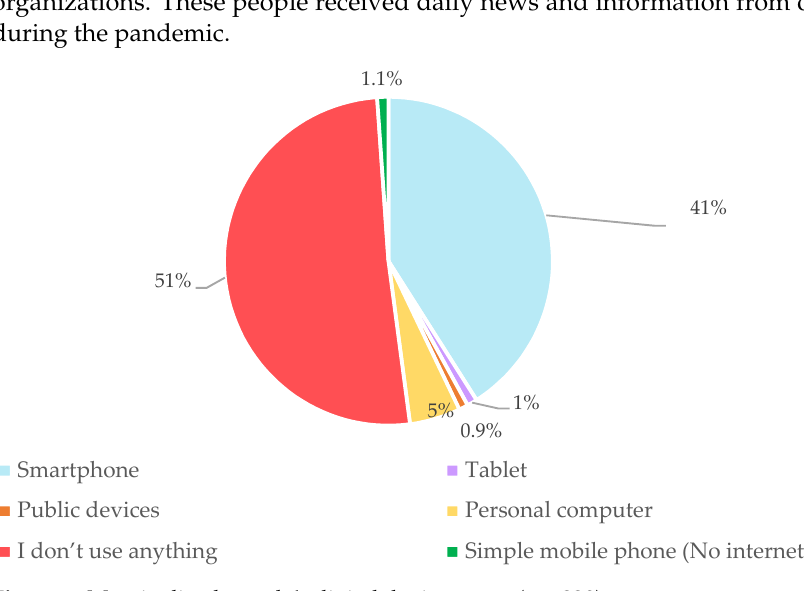
Figure 2. Marginalized people’s digital device usage (n = 220).